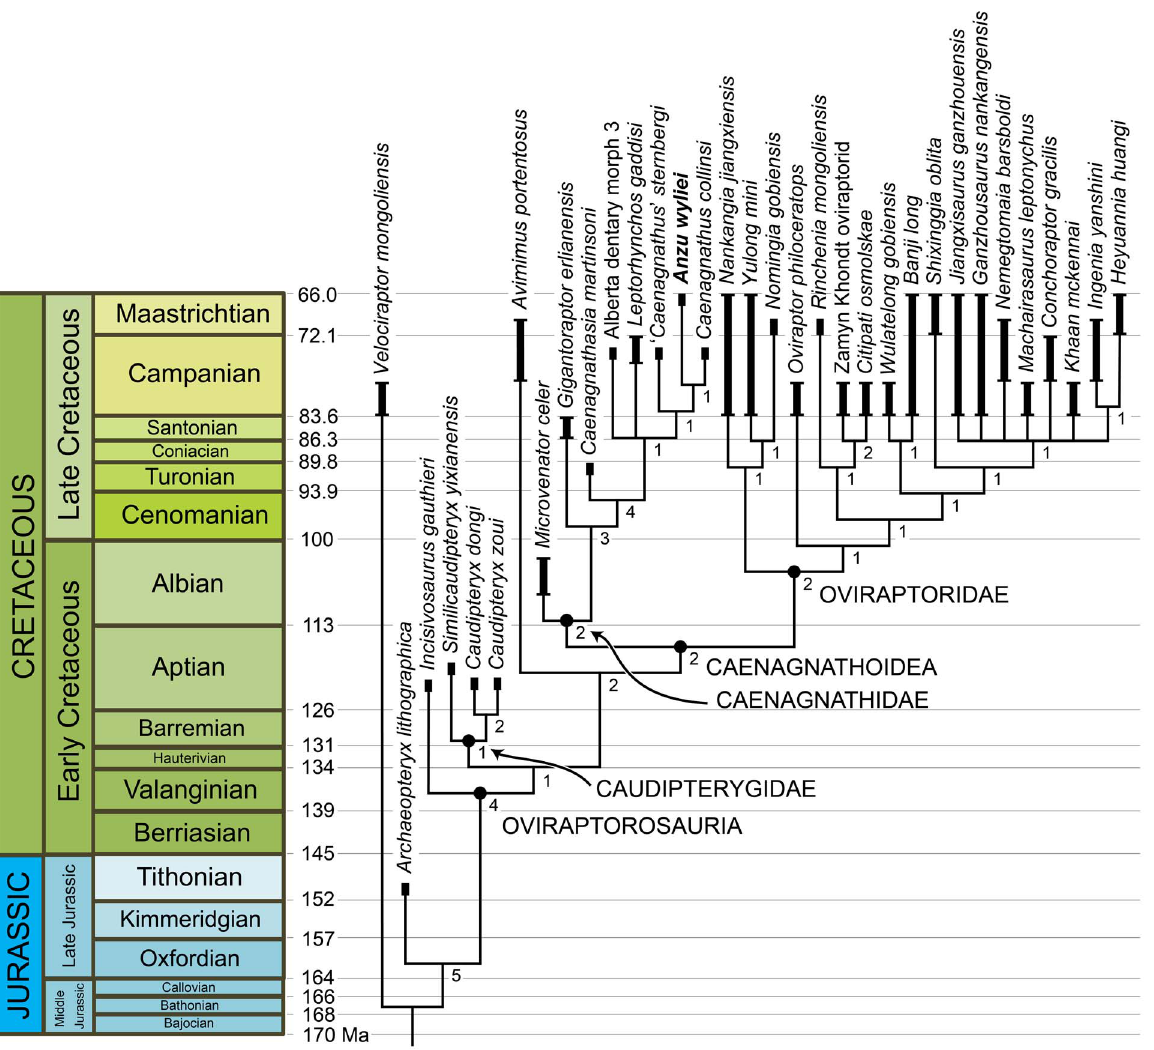
Figure 7. Calibrated phylogeny of oviraptorosaurian theropods showing hypothesized position of Anzuwyliei gen. et sp. nov. Depicted topology is the strict consensus of seven most parsimonious trees of 498 steps resulting from an analysis of 34 taxa (31 oviraptorosaurs) scored for 230 morphological characters (Figure 6B). Numbers adjacent to each node are Bremer support values; named nodes are indicated with black dots. Thick black bars indicate stratigraphic ranges of each taxon; small crossbars at ends of some bars indicate taxa that are especially poorly stratigraphically constrained (e.g., most Asian Late Cretaceous forms). Time scale follows [98]. Sources for stratigraphic ranges of included taxa are provided in Table S9 in File S1. structure. The sternal plates closely resemble those of oviraptorids in having a pair of well-developed lateral processes [18]. The distal end of the radius is peculiar in being divided into a pair of tuberosities. The manus is proportionally large, and, like those of other derived caenagnathids, its unguals exhibit proximodorsal ‘lips’ that are more prominent than in most other oviraptorosaurs. Although incompletely known in Anzu , manual digits II and III were probably elongate, as in other derived caenagnathids in which the manus is better known (e.g., Chirostenotes pergracilis , Elmisaurus rarus , Hagryphus ) [34,39,63,64]. The pubic shaft is straight and the ischium is short and distinctly curved. The hind limb elements are gracile, with the tibia being substantially longer than the femur. The pes is incompletely preserved in Anzu , but what is known suggests that its digits were elongate, as in other derived caenagnathids (e.g., Macrophalangia [35]).